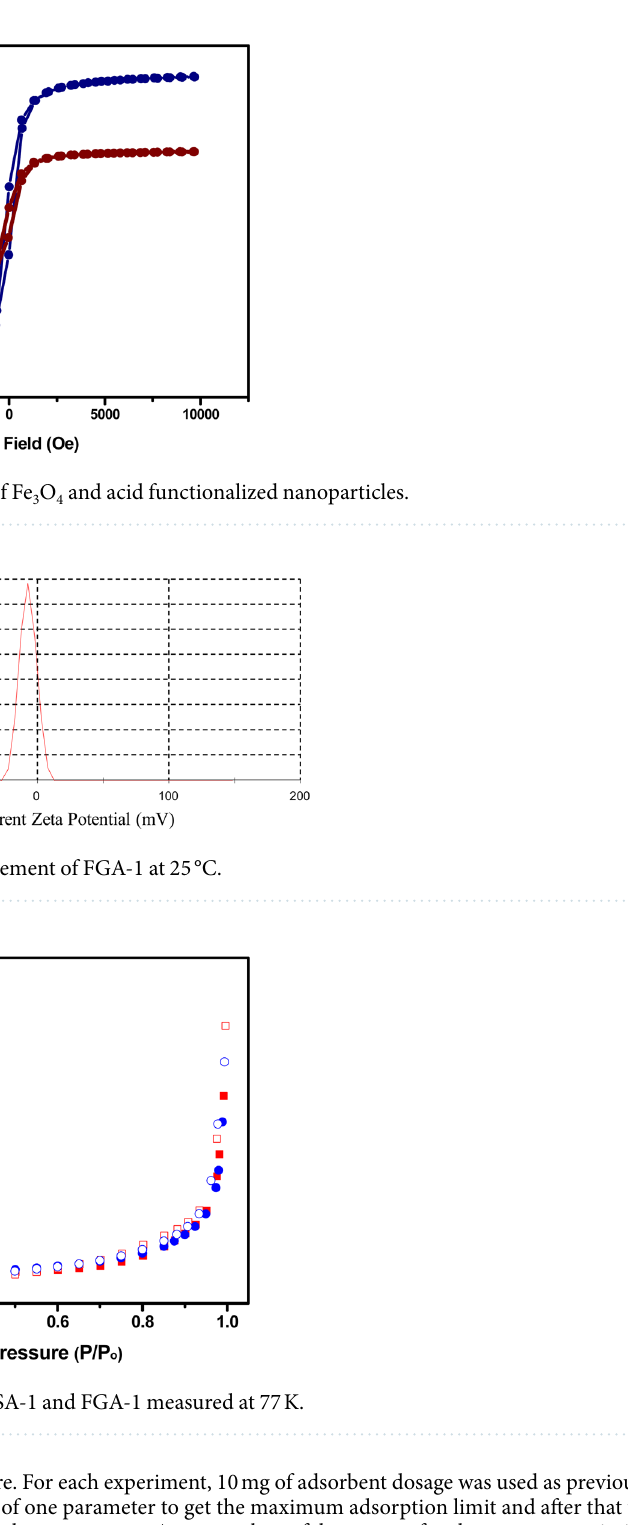
of adsorbent at room temperature. For each experiment, 10 mg of adsorbent dosage was used as previously opti- mized 32 over the variable range of one parameter to get the maximum adsorption limit and after that the same procedure was repeated with all other parameters. Average values of three runs of each parameter optimized were taken with ± 0.01 standard deviation.